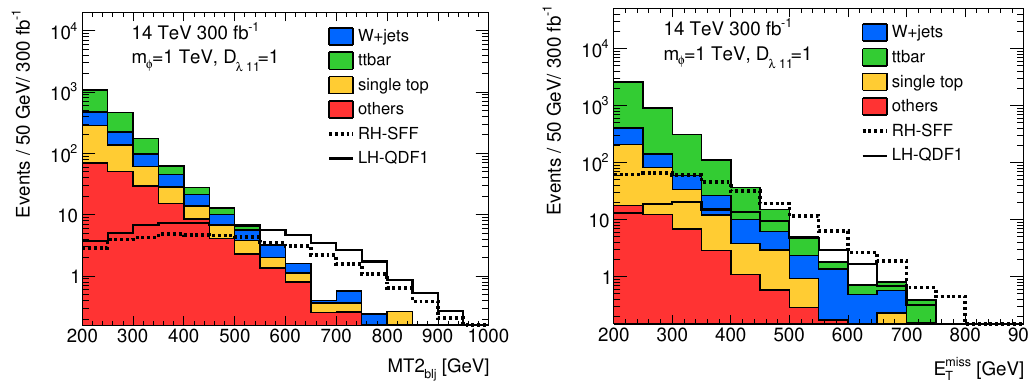
(right) variables for the tj and monotop Figure 12 . Distribution of the m T2 (left) and E miss T analyses respectively for two signal points and for the SM backgrounds. The distributions are shown after all of the selection cuts are applied except the one on the plotted variable. The normalisation corresponds to an integrated luminosity of 300 fb − 1